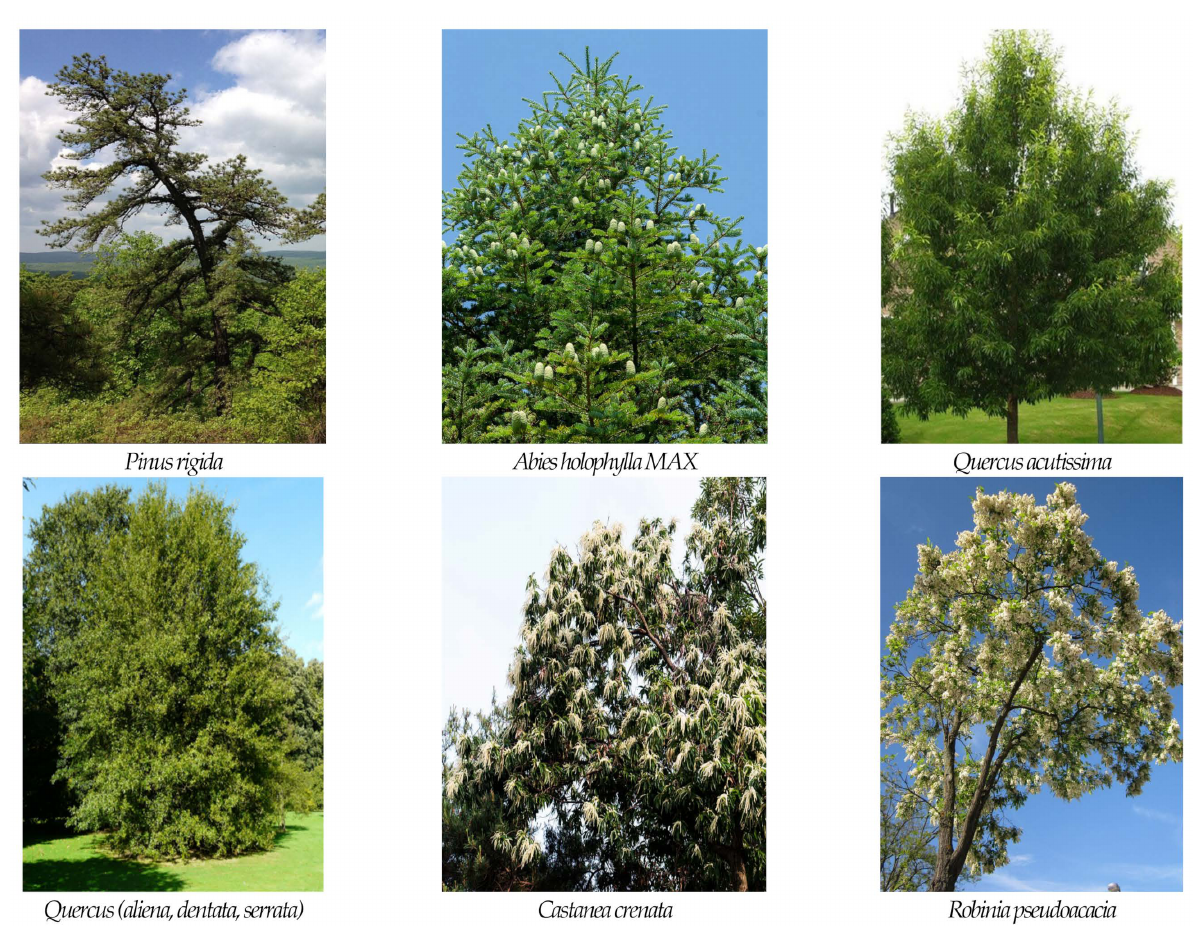
Figure 4. Photographs of Nine Tree Species Used in the Study (Wikipedia,